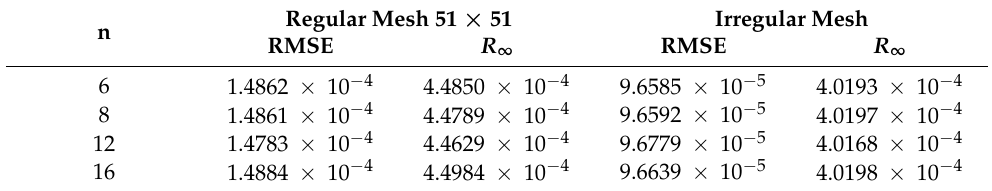
Table 2. Example No. 1—comparison of RMSE and R ∞ for different number of virtual points.